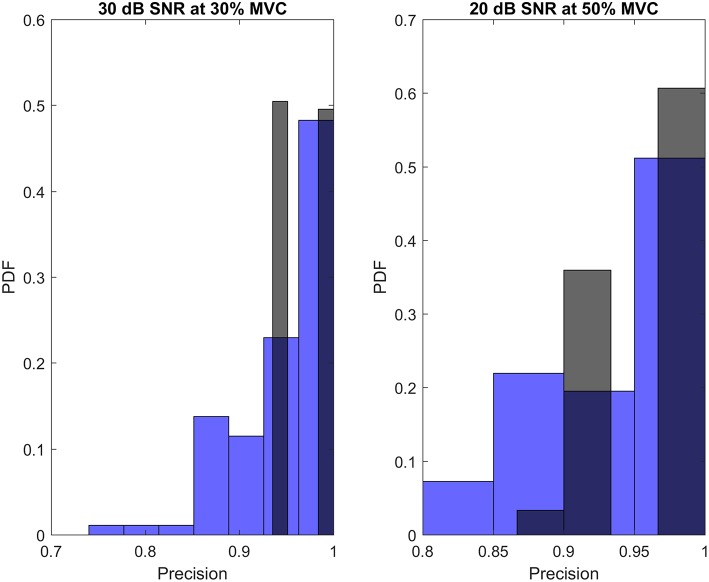
The histogram of the precision of the proposed decomposition algorithm (black), compared to the one form gCKC (blue) for 30 dB SNR at 30% excitation level (left), and 20 dB SNR at 50% excitation level (right).